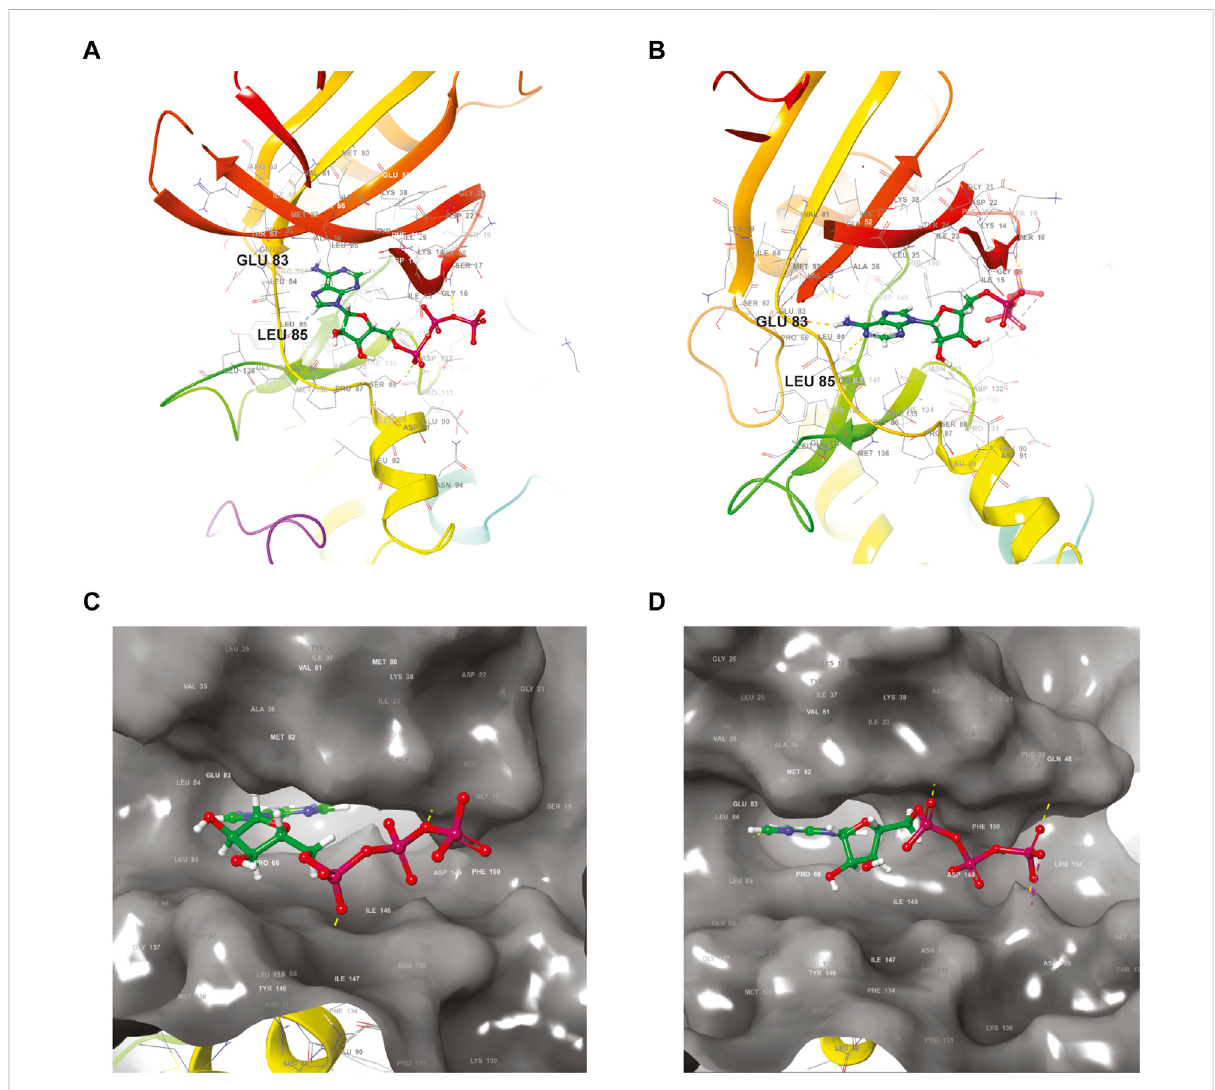
FIGURE 1 Structural comparison of the ATP-binding site of the two closely related CK1 isoforms delta and epsilon. (A,B) Ribbon diagrams of the polypeptidicbackbonesofCK1delta (A) (PDBaccessioncode6RCG)andCK1epsilon (B)